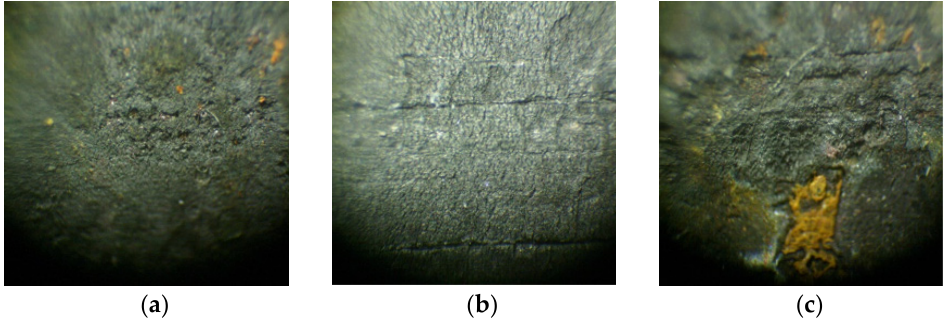
Figure 10. Photos of the corroded area with increasing chloride concentration after 1 year: ( a ) 0.0%, ( b ) 3.0%, and ( c ) 7.0% (cover depth: 45 mm, w / c :